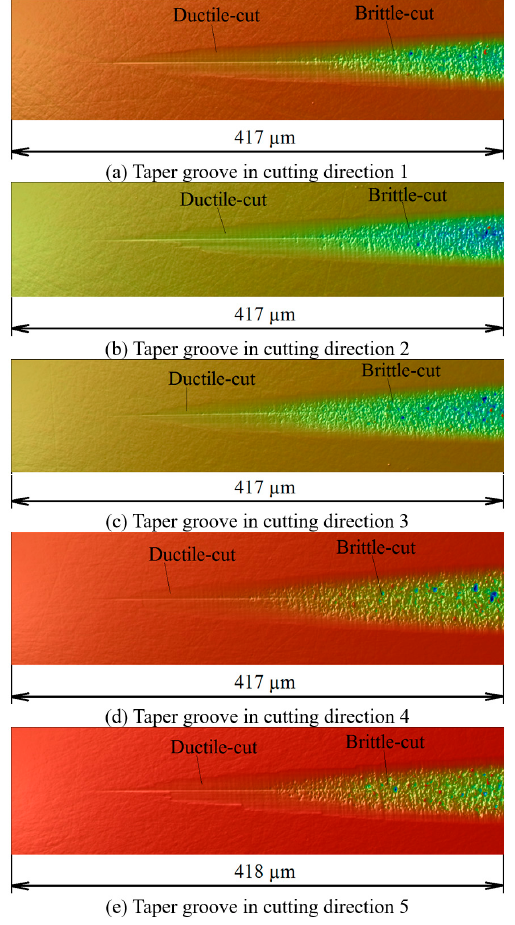
Figure 11. 3D morphologies of the taper grooves.